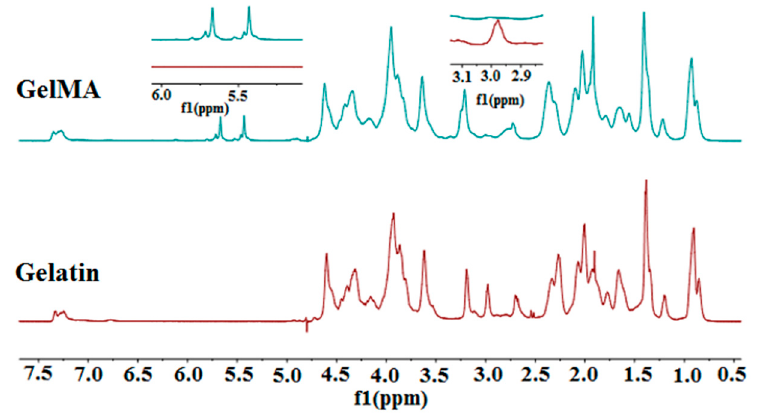
Figure 1. 1 H-NMR spectra of methacrylated gelatin (GelMA) and neat gelatin.